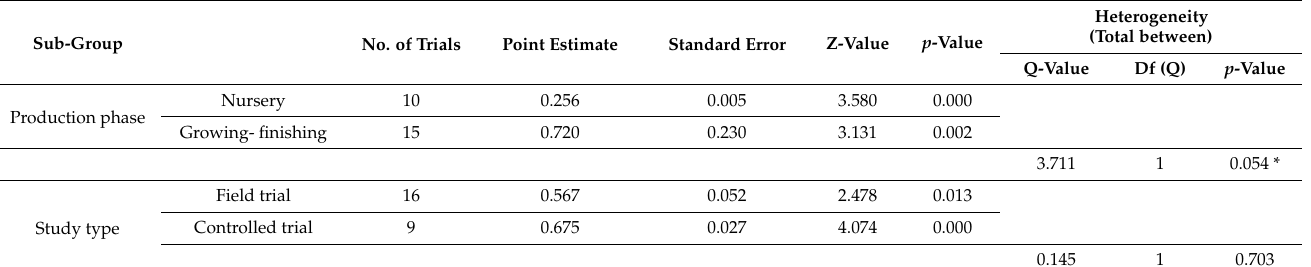
Table 2. Subgroup analysis for the effect size (SMD) of ADWG; production phase and study